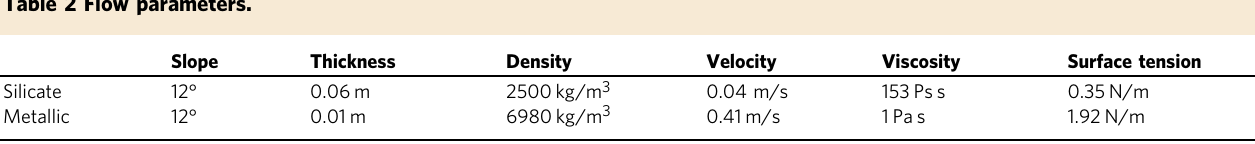
Table 2 Flow parameters.